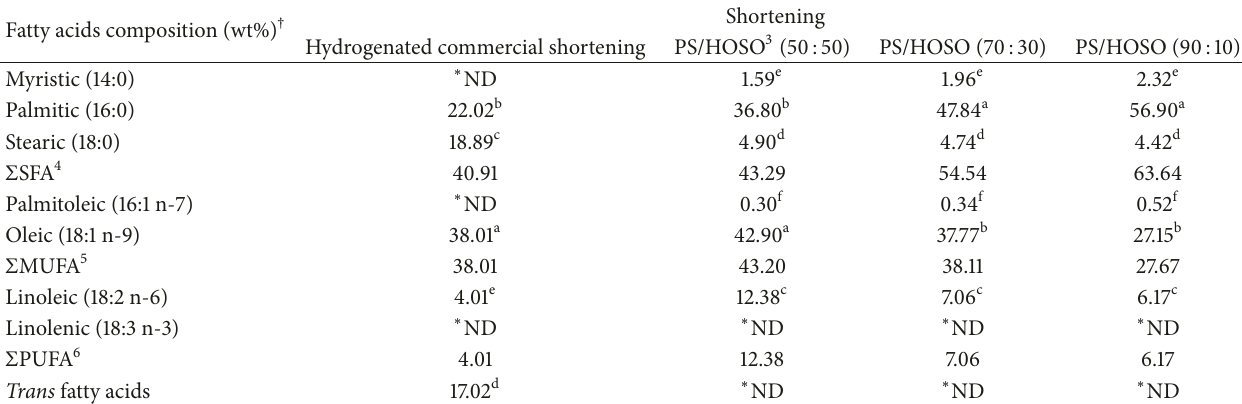
Table 3: Fatty acid compositions of zero- trans crystallized fats produced from palm stearin-high oleic safflower oil blends compared to commercial hydrogenated shortening 1,2 .